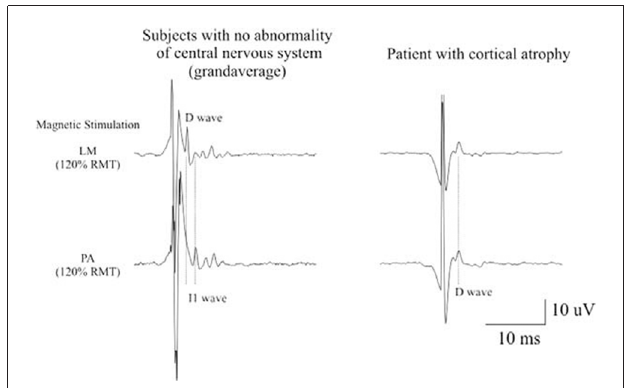
FIGURE 2 | Epidural activity recorded in a patient with cerebral cortex atrophy. Descending volleys evoked by latoro-medial magnetic stimulation and posterior-anteriormagnetic stimulation at 120% resting motor threshold (RMT) in five patients with no abnormality of the central nervous system and at the maximum stimulator output in one chronic alcoholic patient. The grand averages of epidural volleys recorded in patients with no abnormality of central nervous system are shown on the left and the averages of epidural volleys (of 10 sweeps) recorded in the patient with cerebral cortex atrophy are shown on the right. The latencies of the D and I1 waves evoked by LM and PA magnetic stimulation are indicated by vertical dotted lines. In control subjects, LM stimulation evokes a large D wave followed by 5 I waves; PA stimulation evokes only I waves. In the patient with cerebral cortex atrophy the output evoked by LM and PA magnetic stimulation is similar. Both techniques evoke a large D wave and no clear I waves but only two very small and delayed peaks (Di Lazzaro et al.,